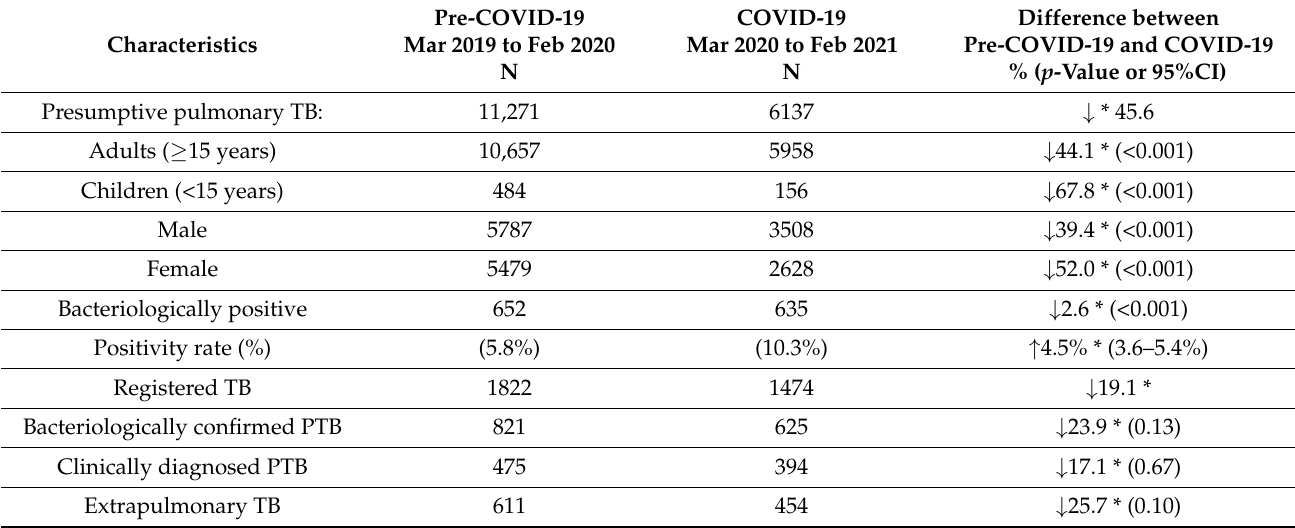
Table 1. Characteristics of persons with presumptive pulmonary TB and registered TB in eight selected health facilities in Lilongwe, Malawi, during pre-COVID-19 and COVID-19